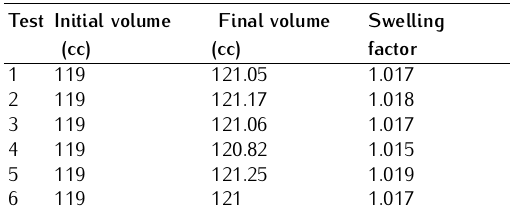
Table 5. Swelling factor during experiments.